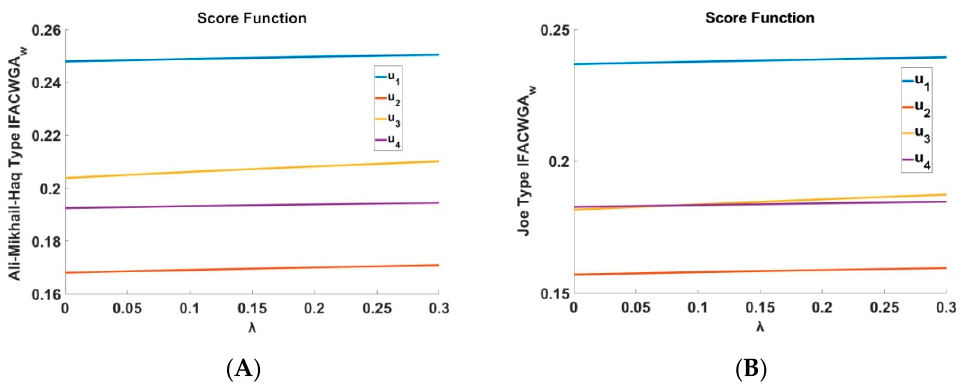
IFACWGA score result. w